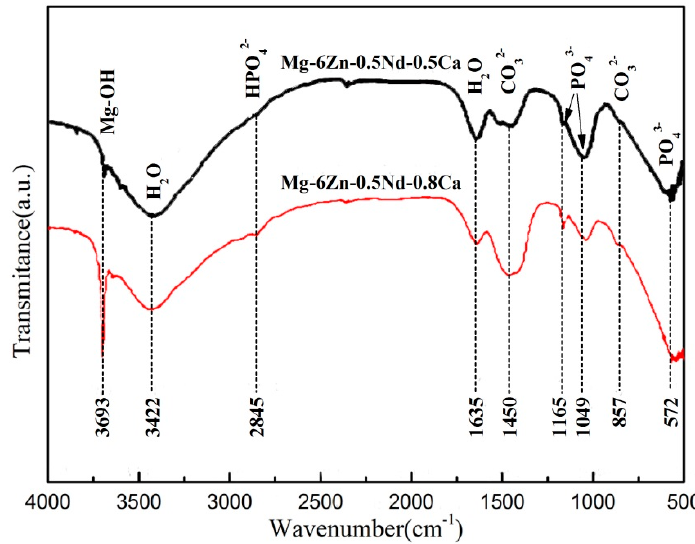
Figure 9. FTIR spectra of corrosion products of the extruded Mg-6Zn-0.5Nd-0.5/0.8Ca alloys after the aging treatment.